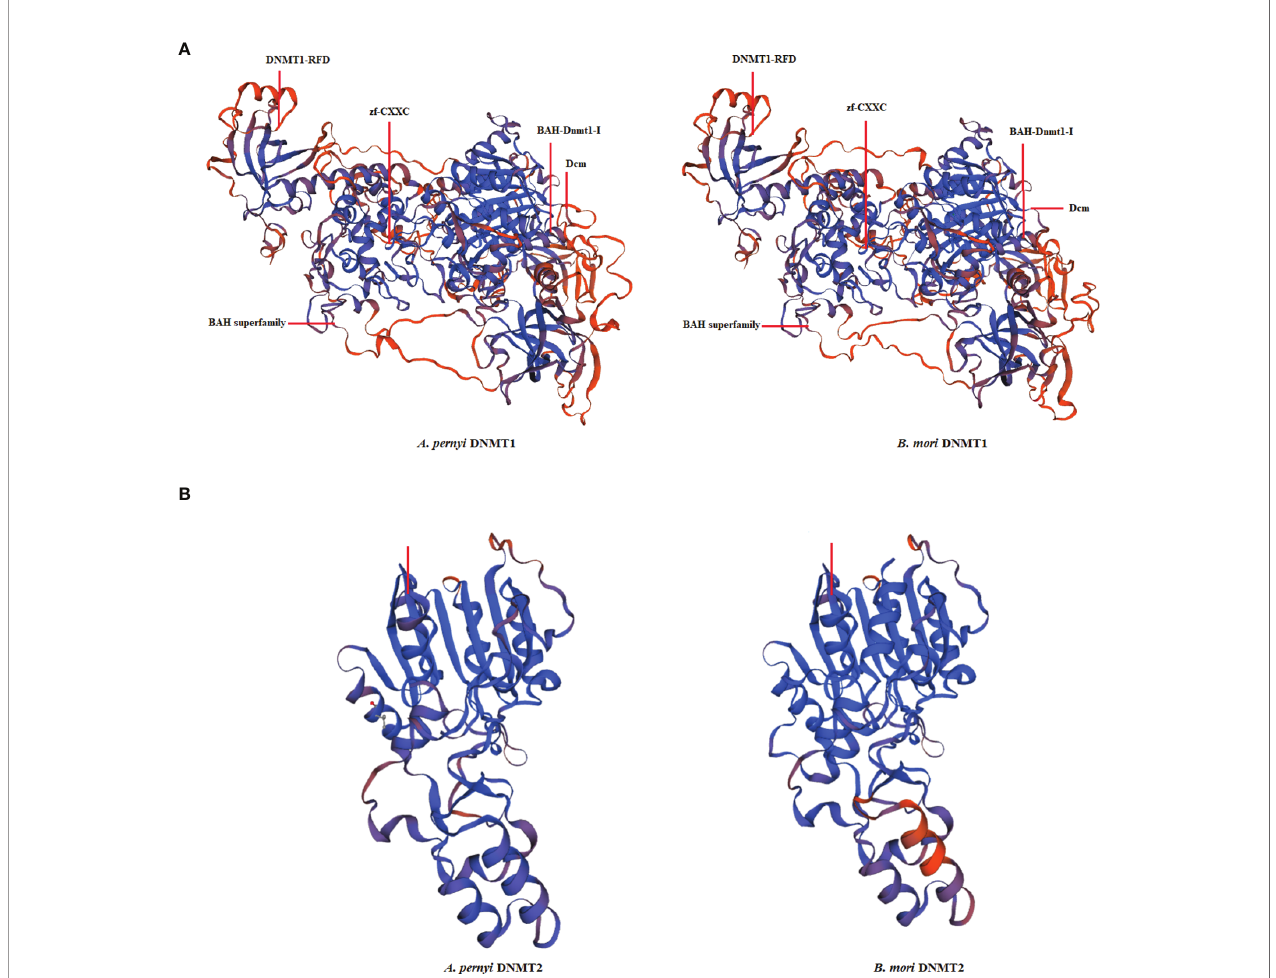
FIGURE 3 | The tertiary structure of A. pernyi DNMT-1 (A) and DNMT-2 (B) proteins in comparison with Bombyx mori DNMT-1 and DNMT-2